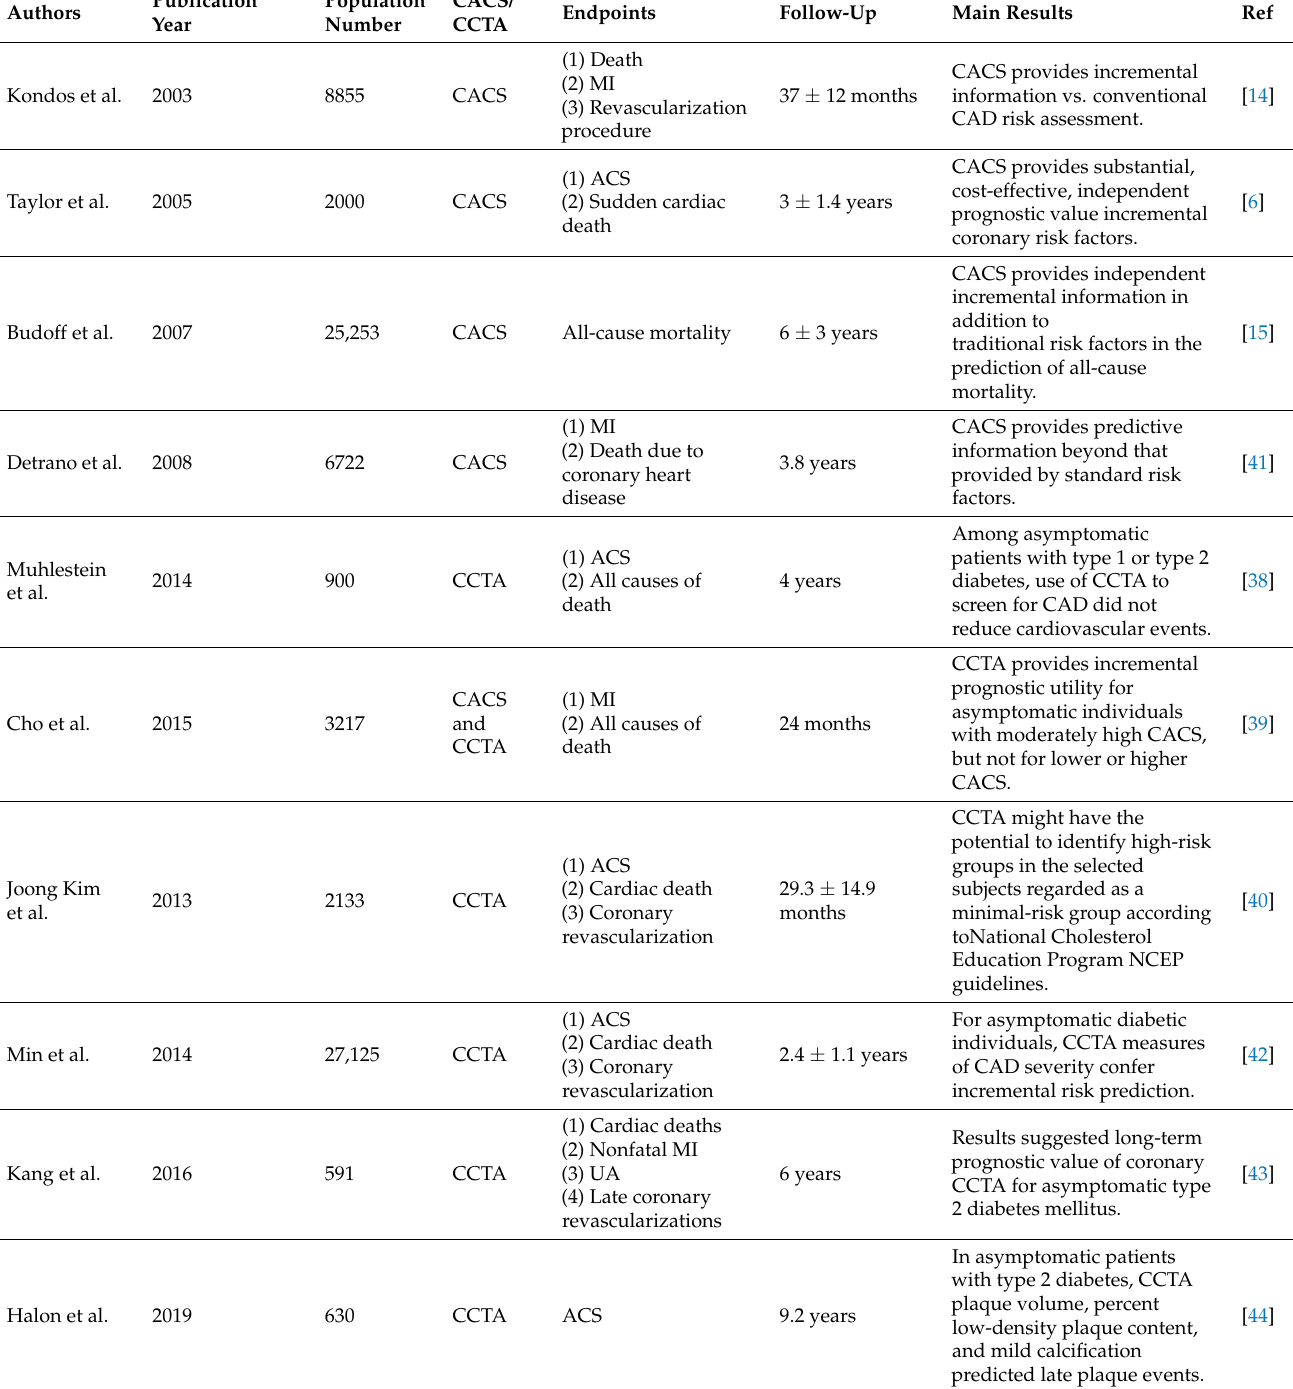
Table 4. Main studies reporting prognostic role of CACS and CCTA among asymptomatic